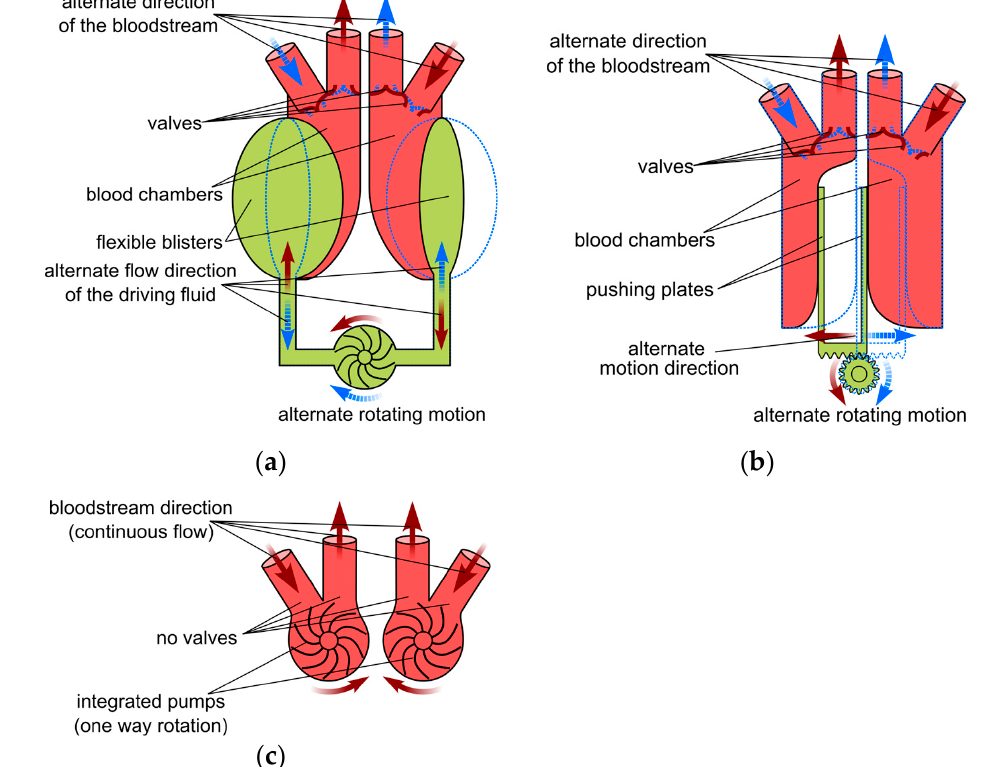
Figure 1. Main TAH types; ( a ) fluid driven; ( b ) electromechanical driven; and ( c ) continuous flow with integrated pump.